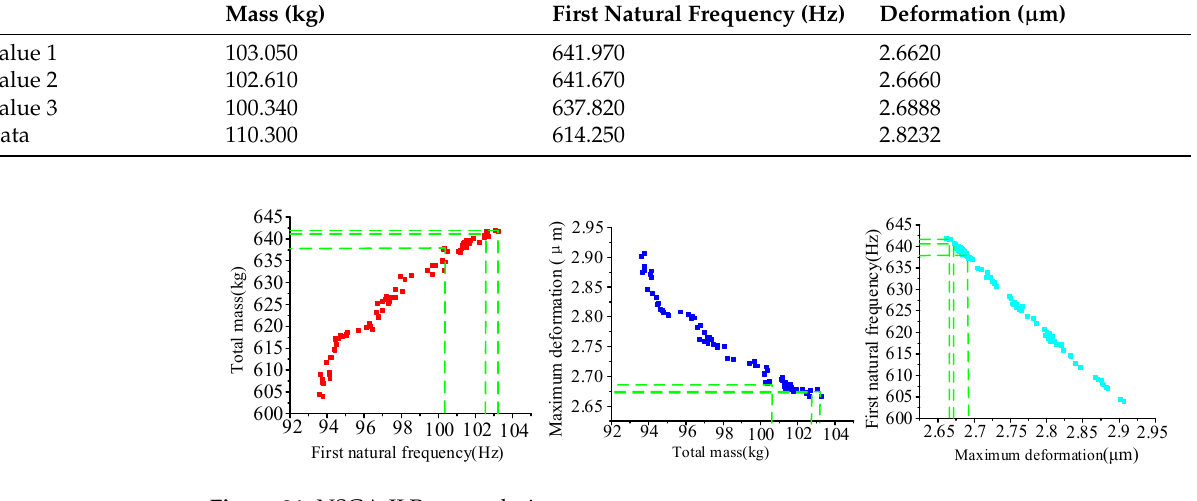
Table 12. Original data and optimization values of optimization objectives. Table 11. Size parameters after and before optimization.